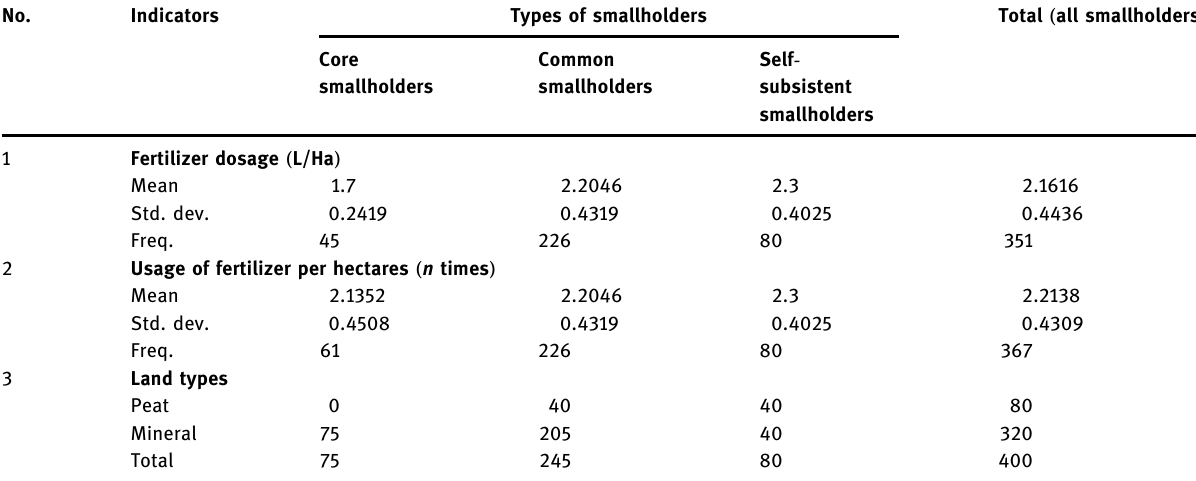
Table 3: Summary statistics of land and fertilizer No.